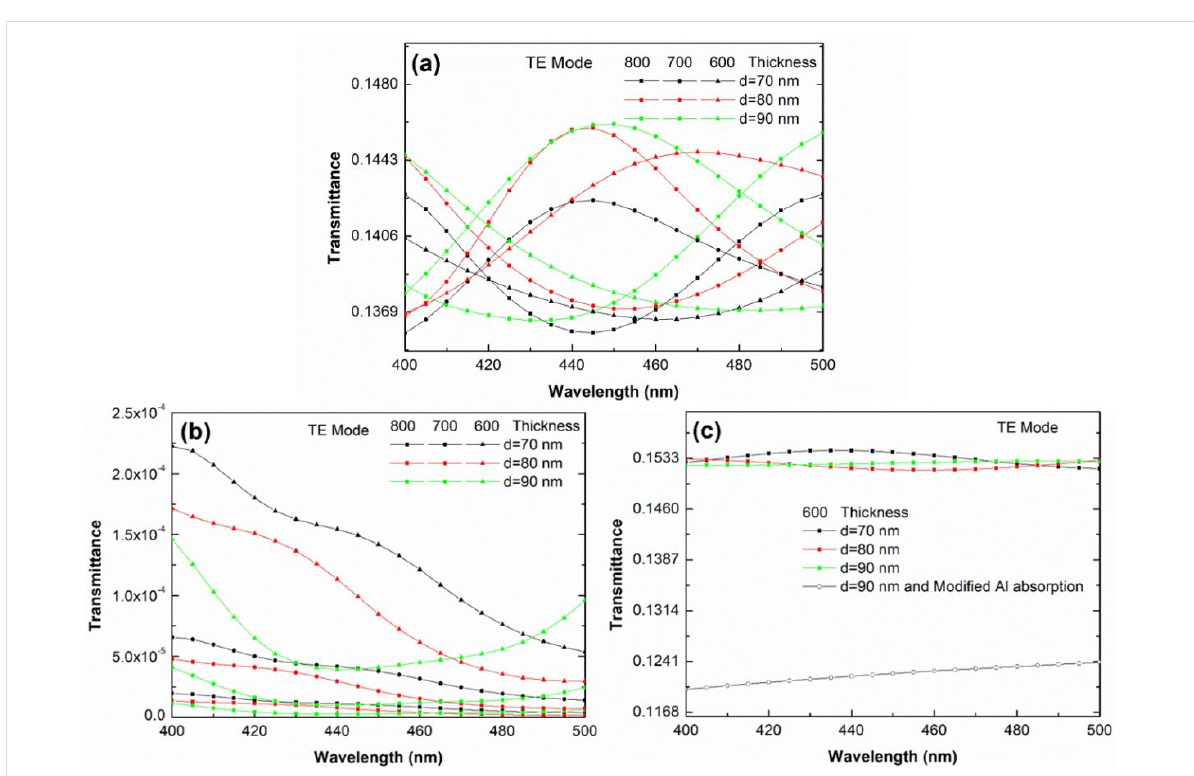
Figure 10: Rigorous coupled-wave analysis (RCWA) results obtained with different Al 2 O 3 thickness and air-hole diameters (a) without Al (b) with Al and (c) with modified Al